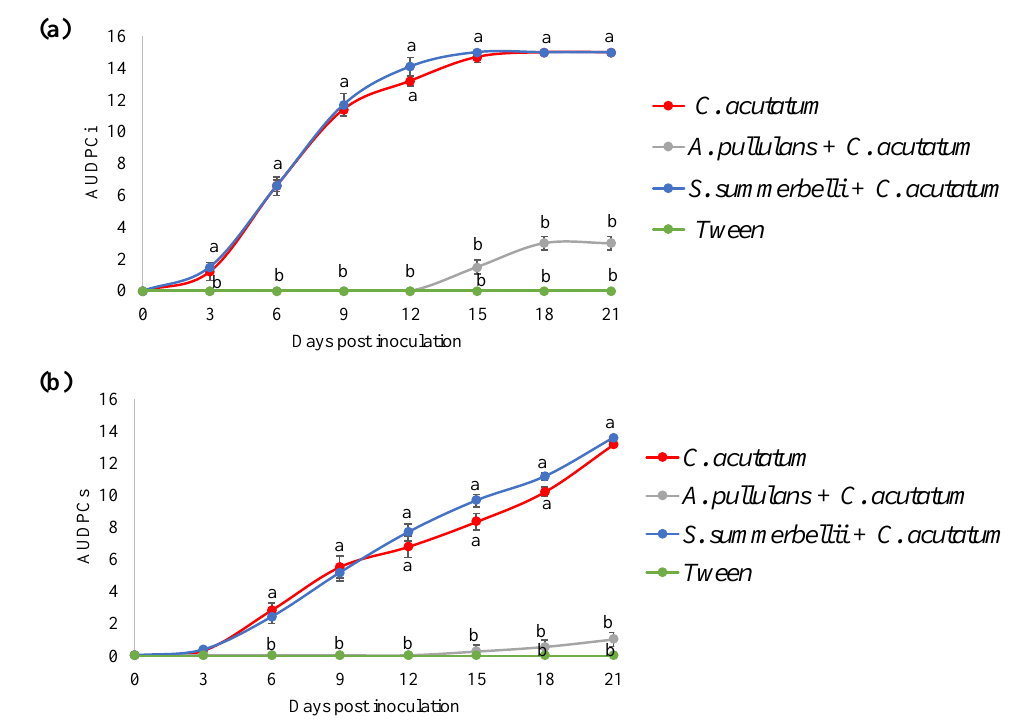
Figure 3. Area under the disease progress curve of incidence (AUDPCi; ( a )) and severity (AUDPCs; ( b )) of anthracnose in olive fruits for the different treatments, over 21 days of post-inoculation with the pathogen Colletotrichum acutatum . Treatments: fruits inoculated with Tween 80 (mock-inoculated), with the pathogen (control) and with the endophyte and, 3 days later, with the pathogen ( A. pullulans + C. acutatum or S. summerbellii + C. acutatum ). For each day, mean values of the several treatments followed by different letters are significantly different ( p < 0.05, n =